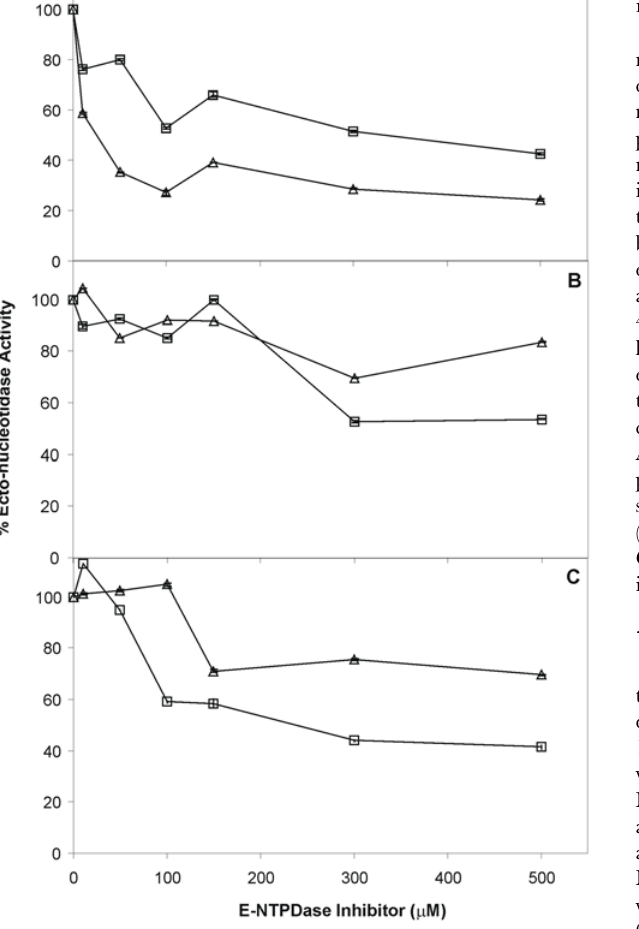
Table 1. Effect of apyrase inhibitors on in vitro infectivity of trypomastigotes.